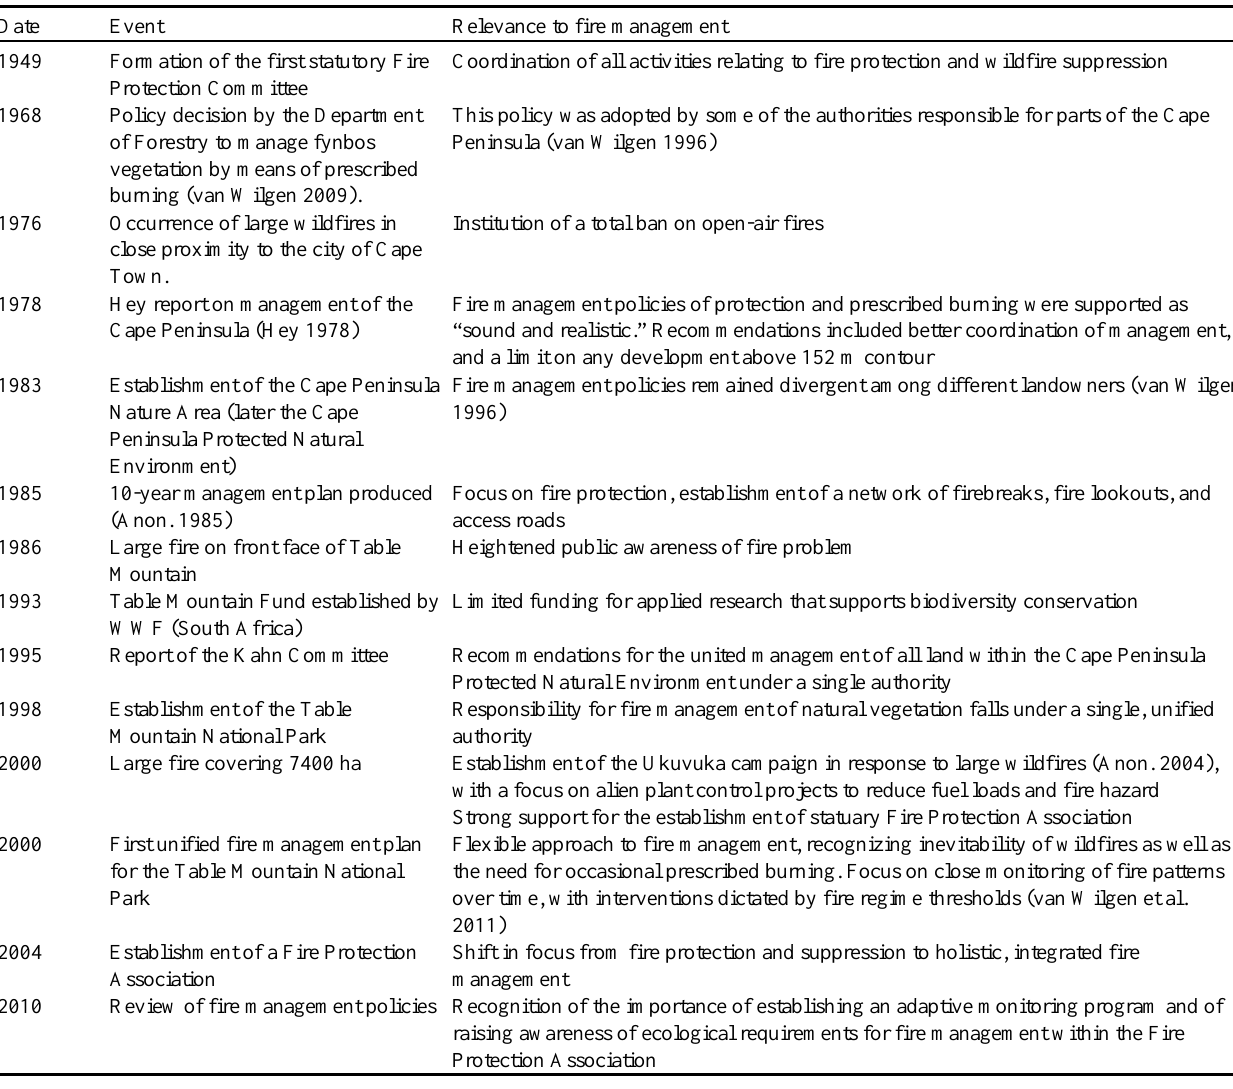
Table 1. Salient events affecting the management of the Table Mountain National Park in the late 20th and early 21st centuries, and their relevance to fire